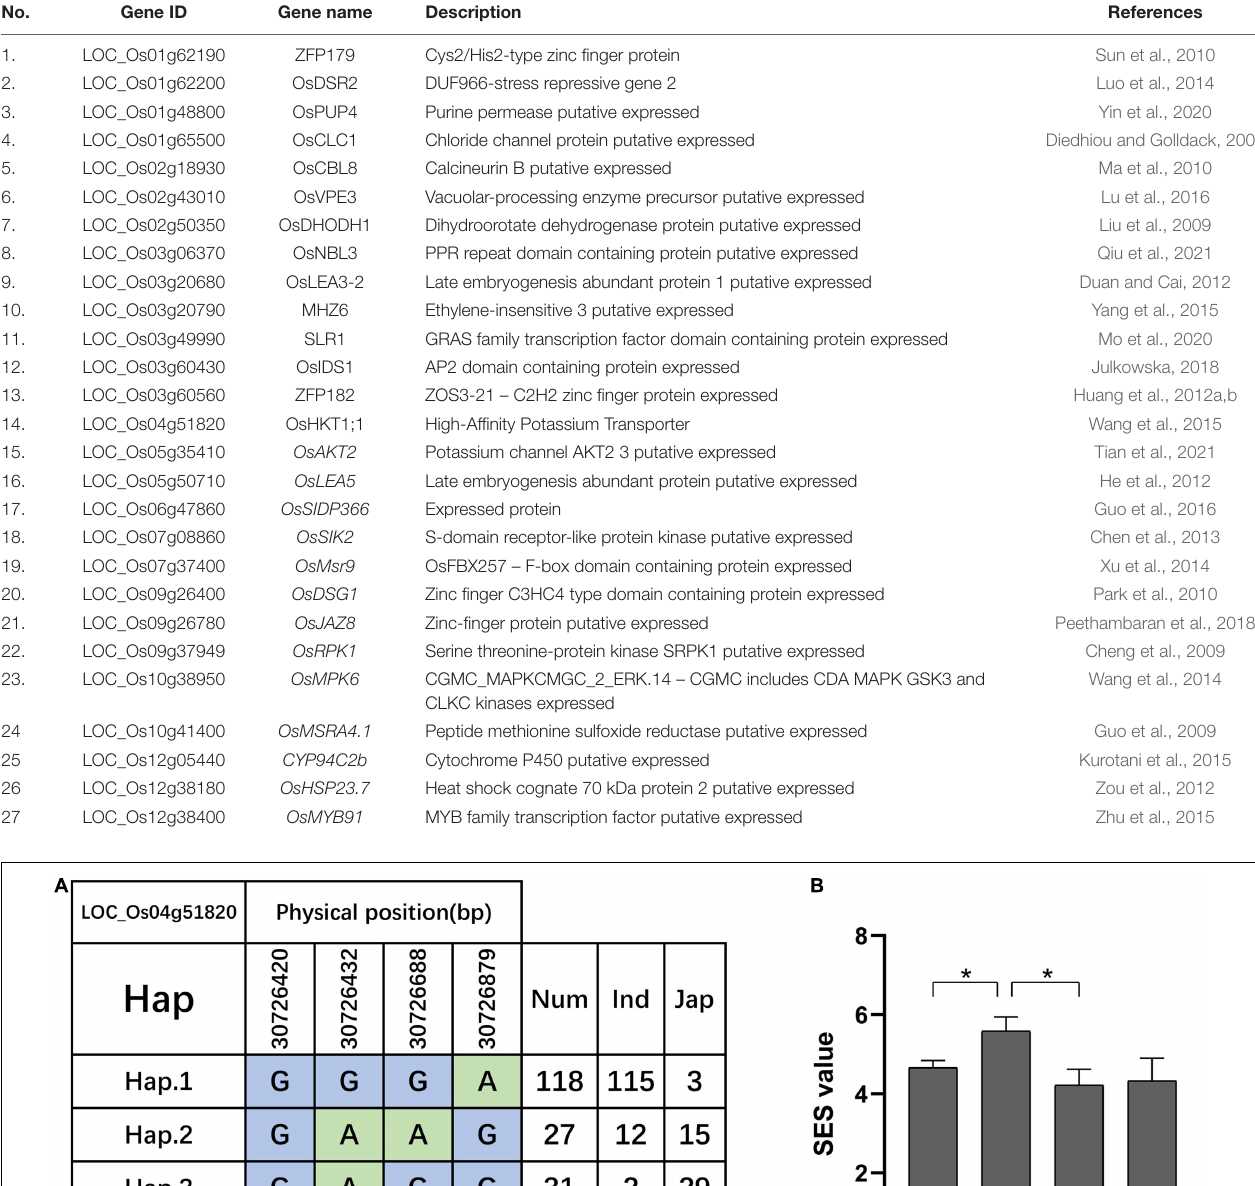
TABLE 2 | Summary of known candidate genes for salt sensitivity. No.